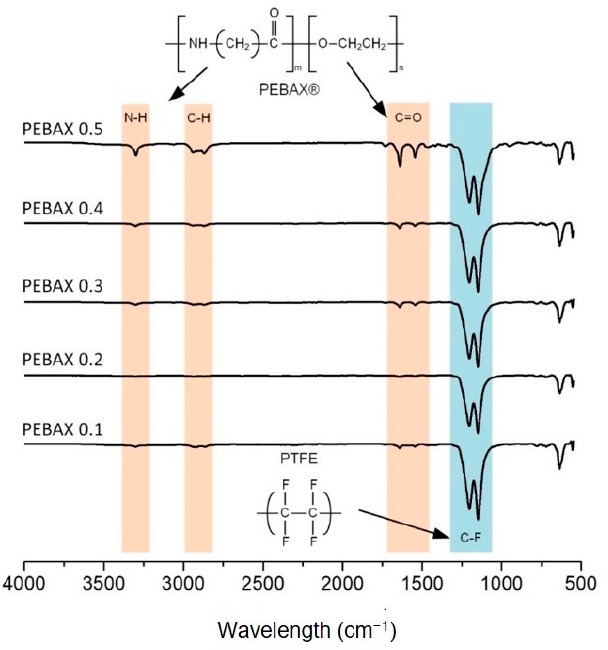
Figure 2. FTIR analysis of coated PTFE with PEBAX concentrations of 0.1–0.5 wt%.